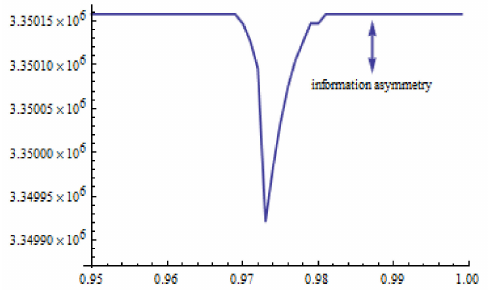
Figure 6. Trend chart of the expected revenue of the retailer.